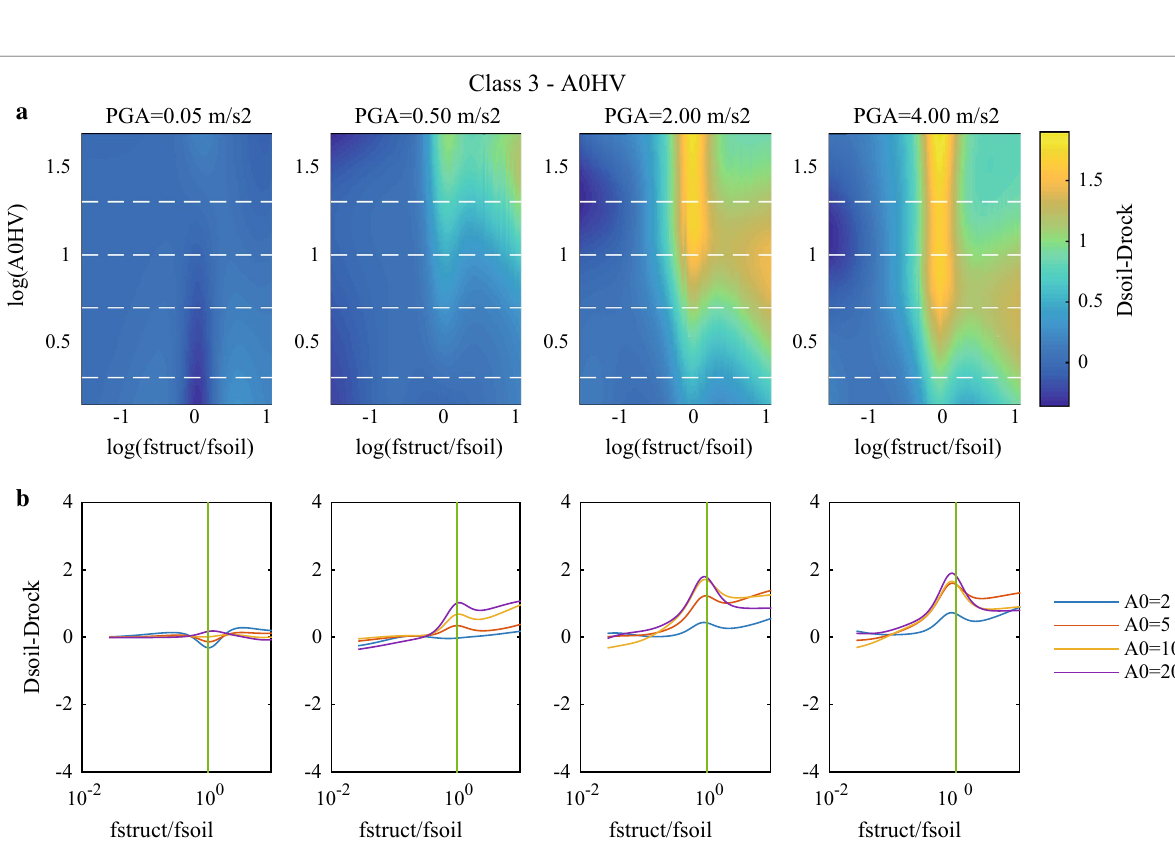
Fig. 8 Variation of the class 3 (RC, low ductility) rock‑to‑soil damage increment as a function of the structure and soil frequency ratio f struct / f soil , and the H / V amplitude, for four different values of PGA (from weak on the left to strong on the right ). The color code on the top frames corresponds to the Δ(DI), while the bottom curves correspond to Δ(DI) as a function of f struct / f soil for four values of A 0HV indicated by horizontal dashed white lines in top